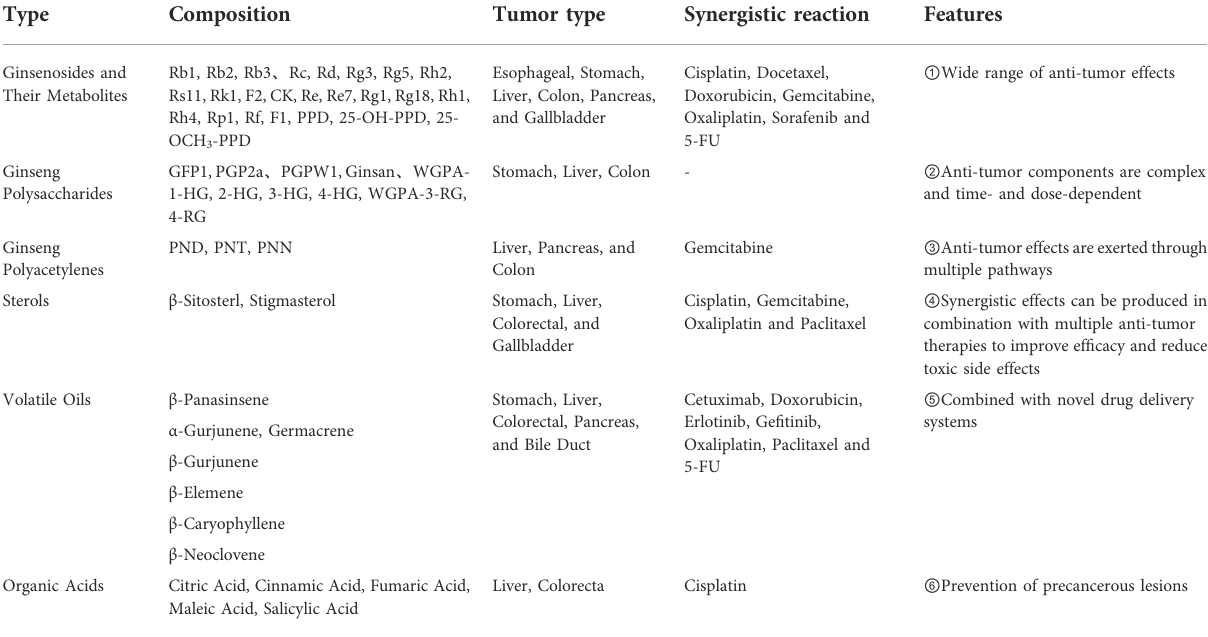
TABLE 1 Tumor types and characteristics of various active components of